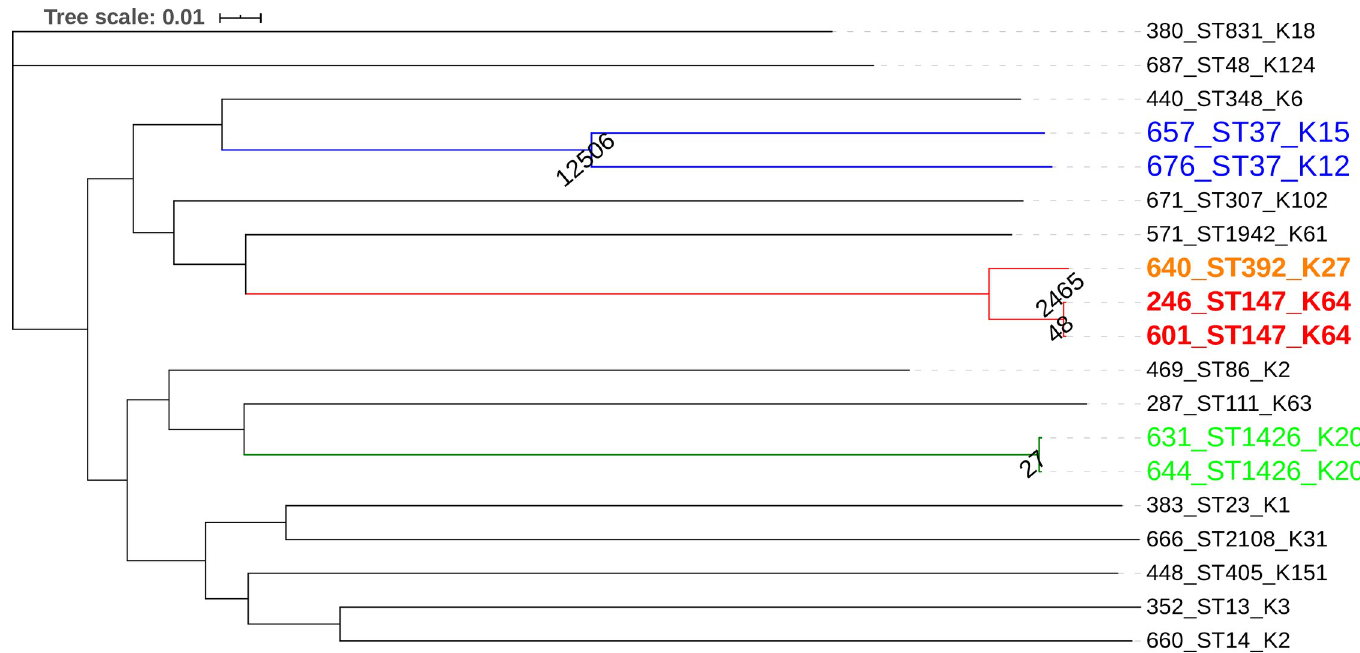
Fig 3. Maximum likelihood tree created from concatenated SNPs sequences. The numbers on the nodes represent the SNPs differences between isolates.